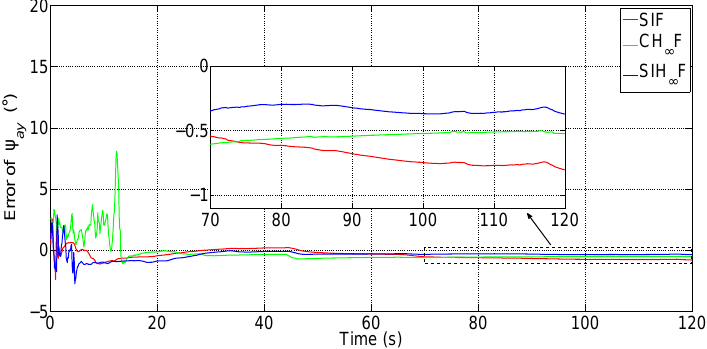
Figure 16. Error of ψ ay (the subfigure is the magnification of the estimation result during 70 s–120 s).